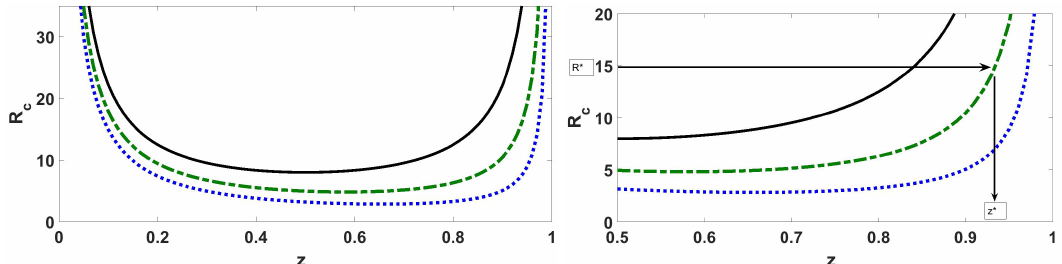
Figure 4. The critical Rayleigh number obtained through the weakly nonlinear analysis is plotted as a function of z 0 for three distinct values of (cid:96) , namely (cid:96) = 0.0001 (continuous line), (cid:96) = 1 (dashed line), and (cid:96) = 2 (dotted line) [8]. Note that R c values get very large as z 0 gets closer to 1. Furthermore, only the interval ( 0.5,1 ) is plotted since convection set in first at the top half of the formation. Reproduced with permission from